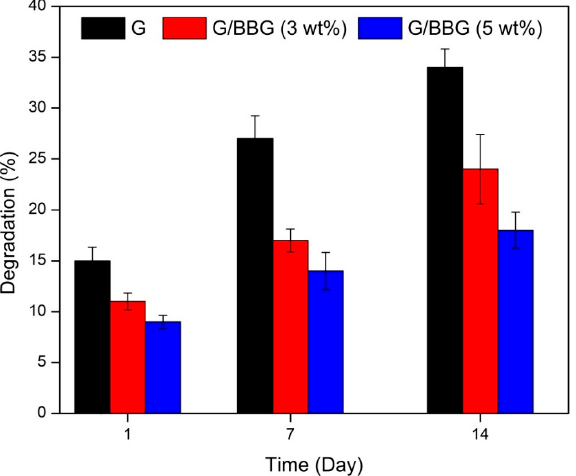
Figure 9. In vitro degradation of the G/BBG nanocomposite hydrogels in PBS at 37